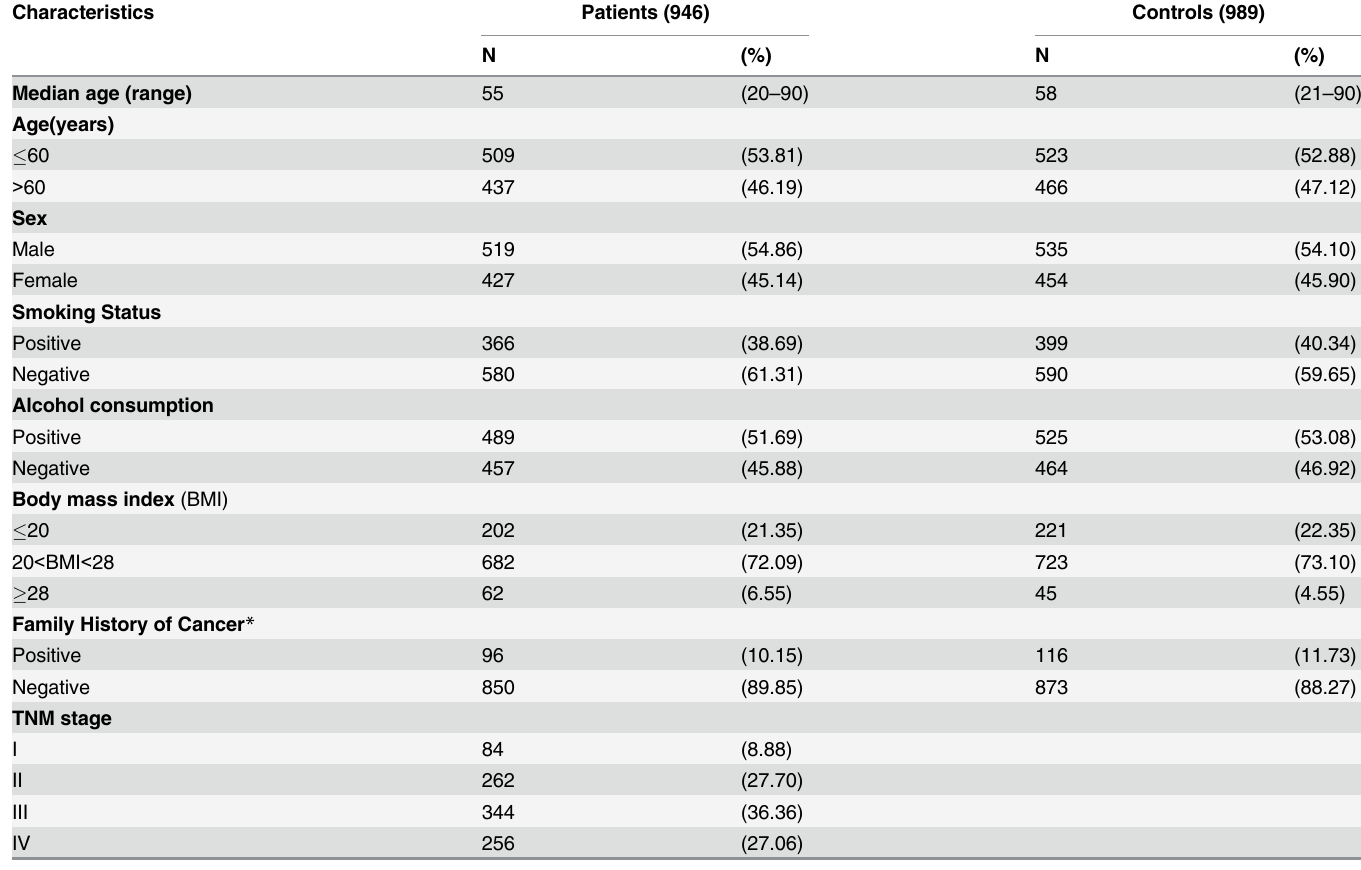
Table 1. The distributions of characteristics in control subjects and patients with colorectal cancer from the Chinese population.